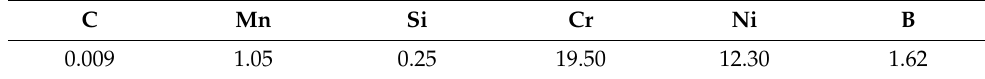
Table 1. Chemical composition of the experimental material (wt. %).